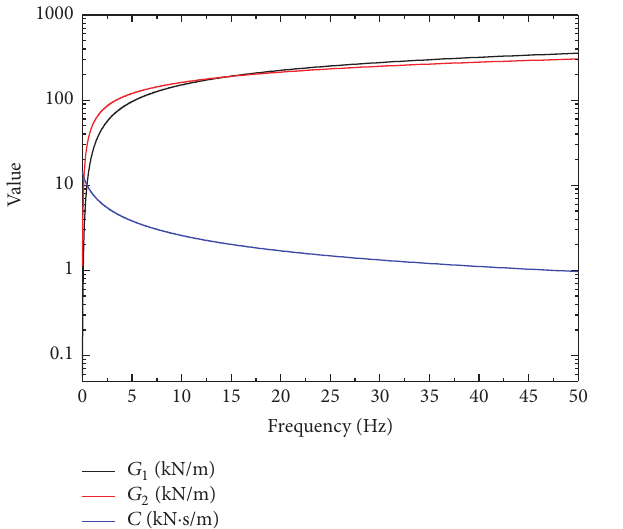
Figure 2: Stiffness and damping coefficient of the FDM.